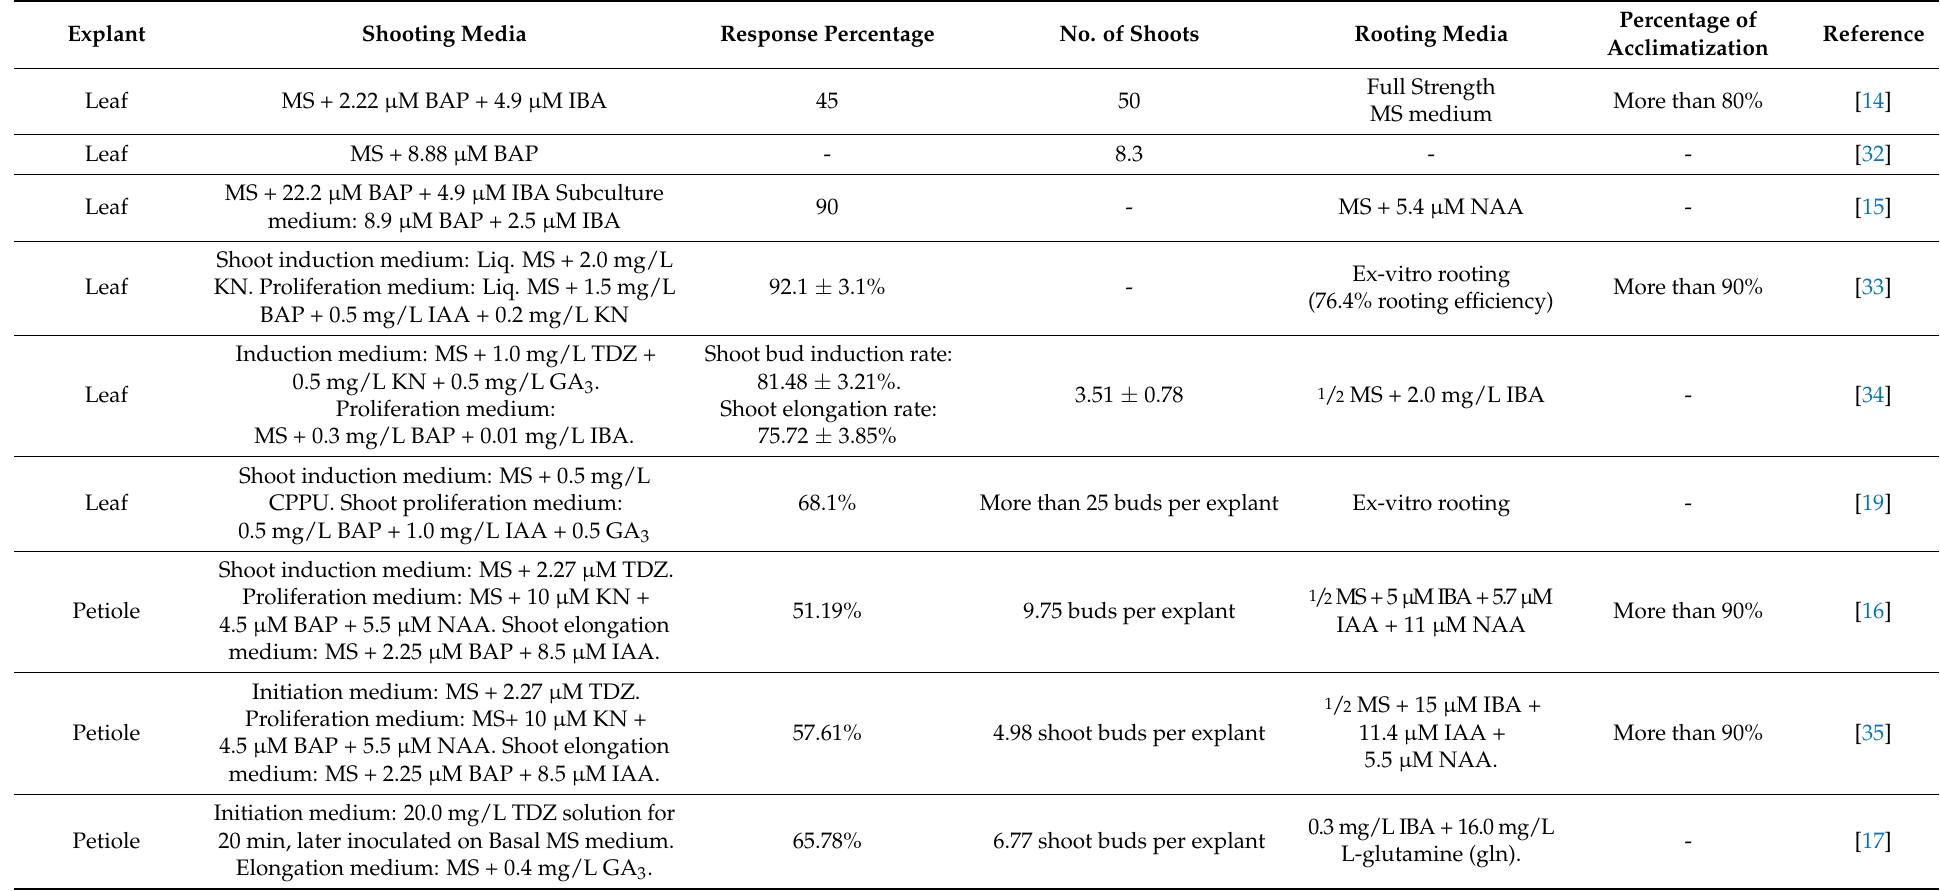
Table 1. Direct organogenesis from various explants of Jatropha curcas